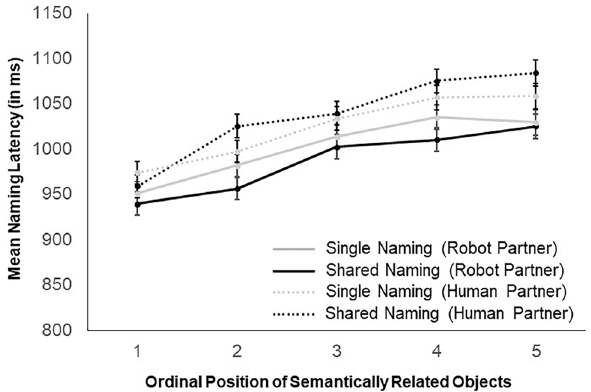
Figure 3. Naming latencies in the naming tasks with a robot and a human partner. Mean naming latency and standard errors (in milliseconds) observed in the current experiment with a robot partner (Block 1) and in experiment 3 from Ref. 26 with a human partner, broken down by ordinal position and naming condition.